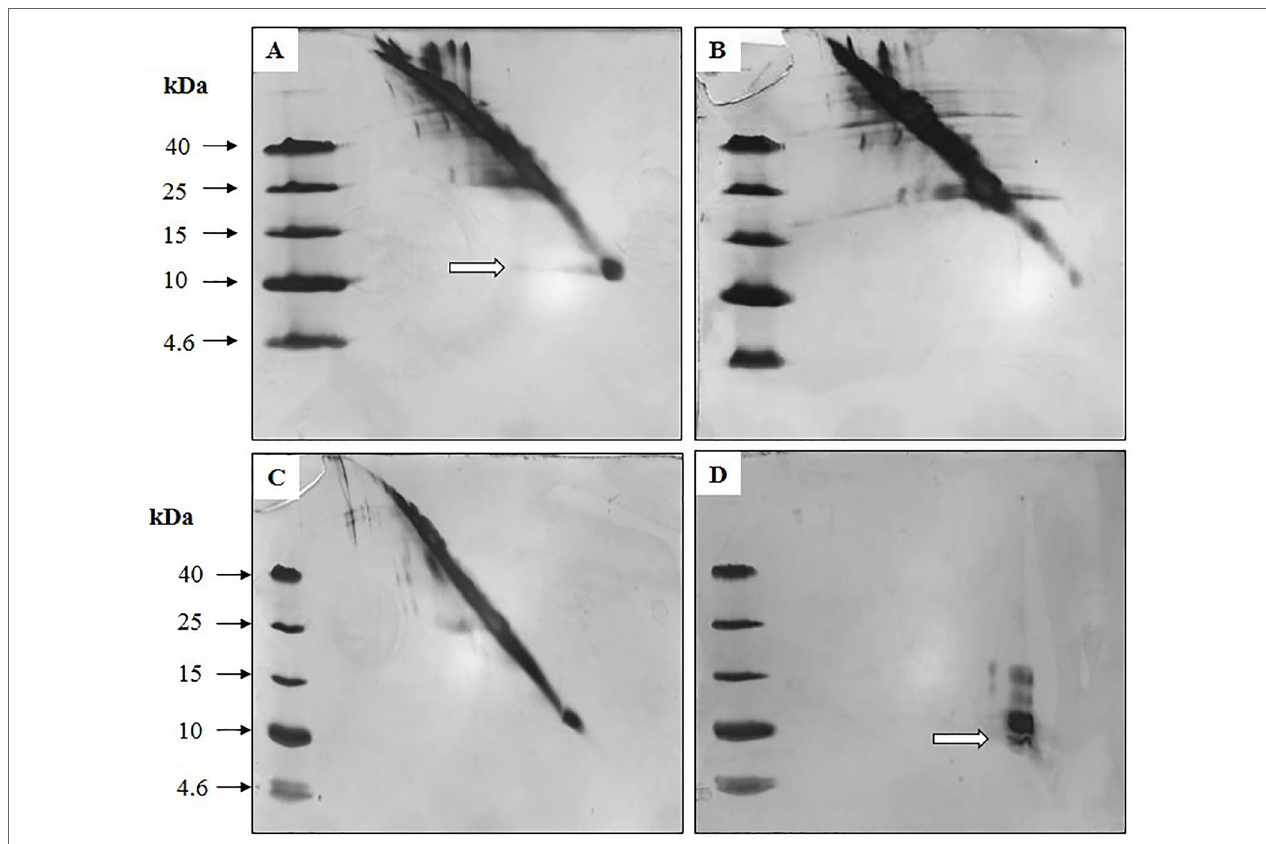
FIgUrE 9 | Silver-stained diagonal gel, identifying intermolecular protein disulfides in (A) NLE SCI-57, (B) NLEN, (C) NLE SCI-57/M2 and (D) EP insulin. Eight microgram of the samples and 1 µg of insulin were loaded on the gel. White arrows indicate proteins with disulfide bridges.